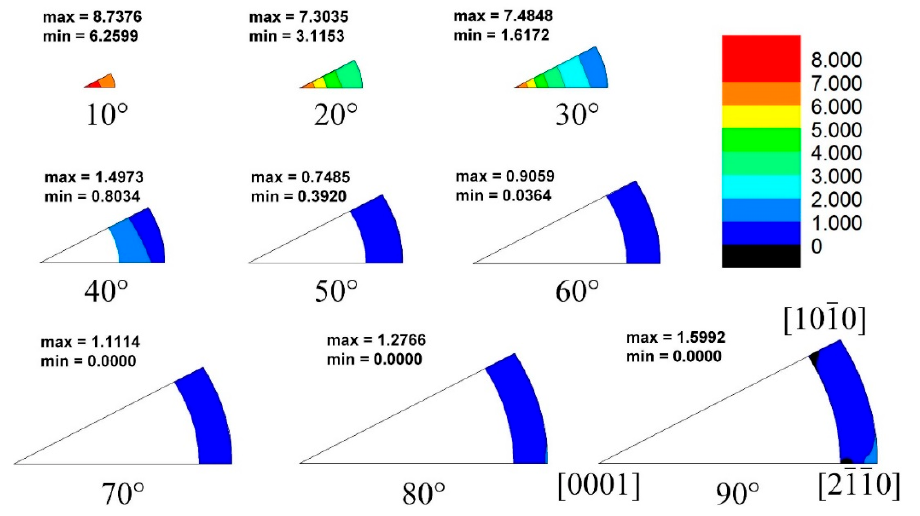
Figure 14. Misorientation distribution map of extruded AZ31 alloy.